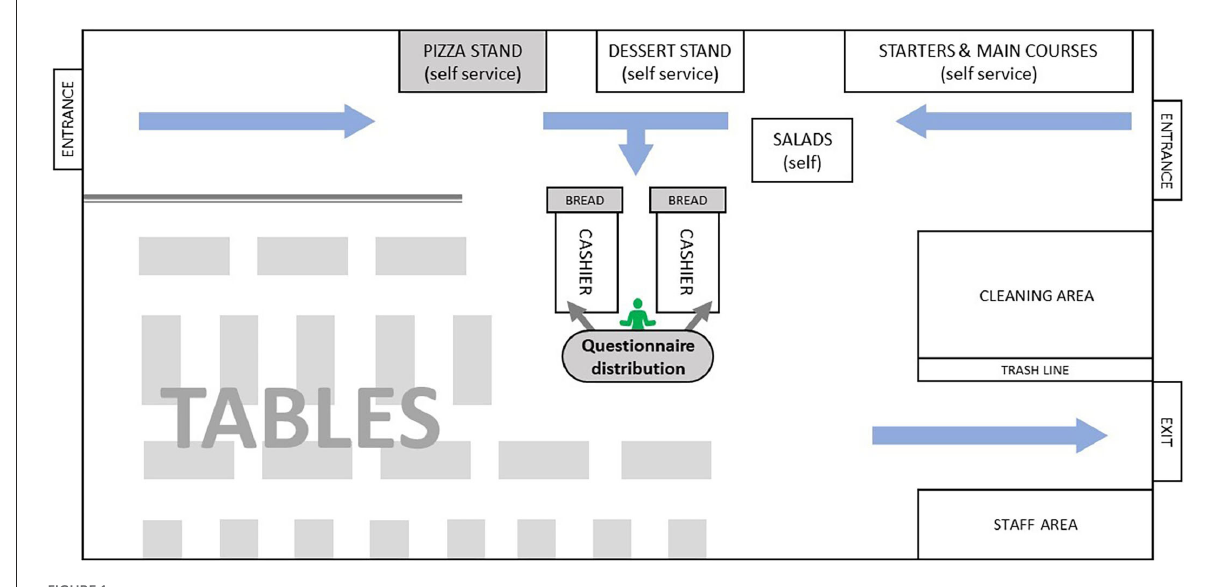
FIGURE1 Plan of the staff and student cafeteria of the Ecole Central of Lyon, France.